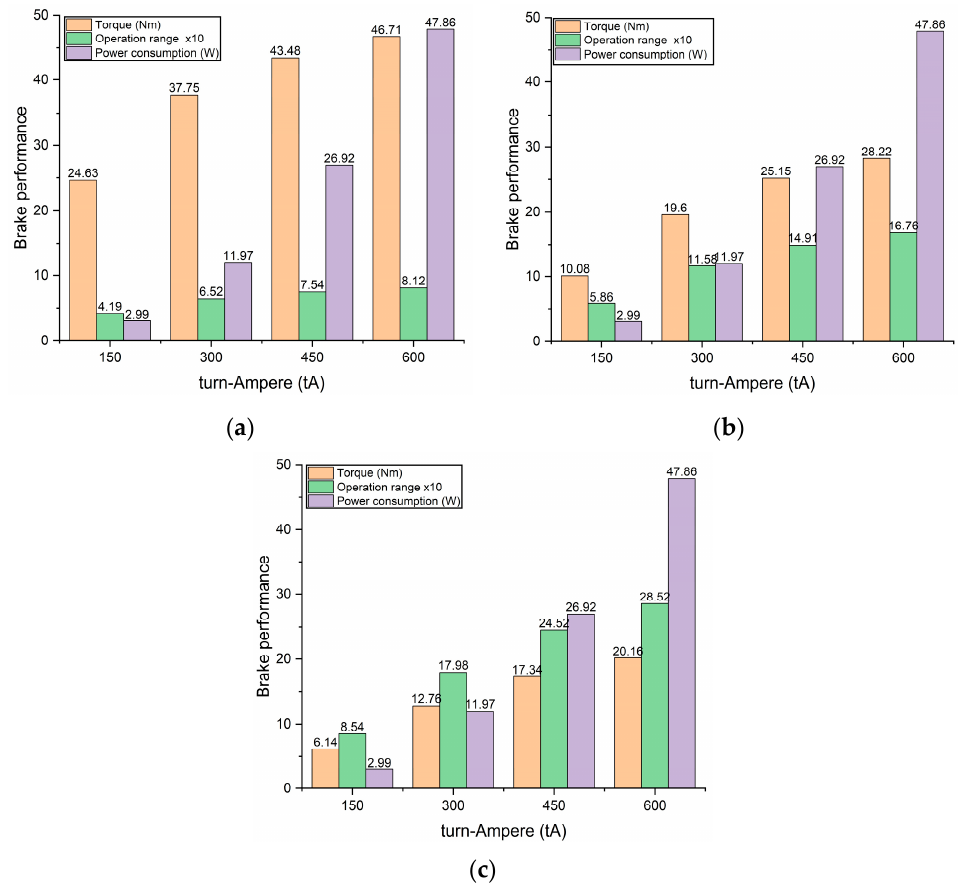
Figure 17. Brake performance results with fluid gap of: (a) 0.5 mm; (b) 0.75 mm; (c) 1 mm.